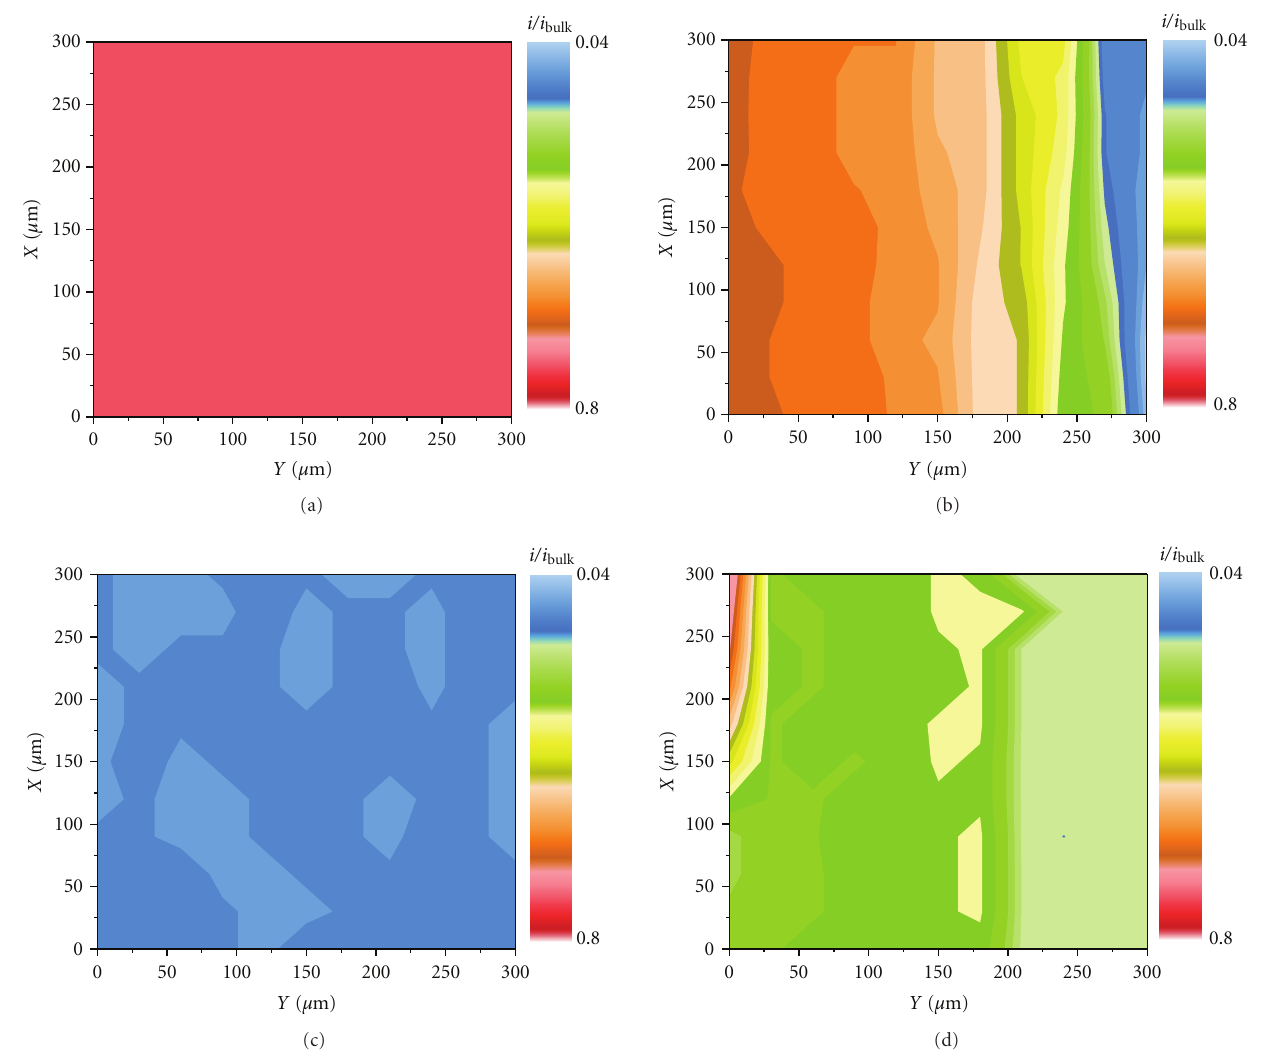
Figure 4: SECM 2D images obtained with a platinum microelectrode ( r = 12 . 5 µ m) in a 0.2mmolL − 1 H 2 SO 4 + 0.1molL − 1 KCl solution (pH = 3.4) for an insulating substrate (a) and a tooth sample at di ff erent times: 0 minutes (b), 60 minutes (c), and 70 minutes (d). Image (d) was recorded after solution stirring. Scan rate = 20 µ ms − 1